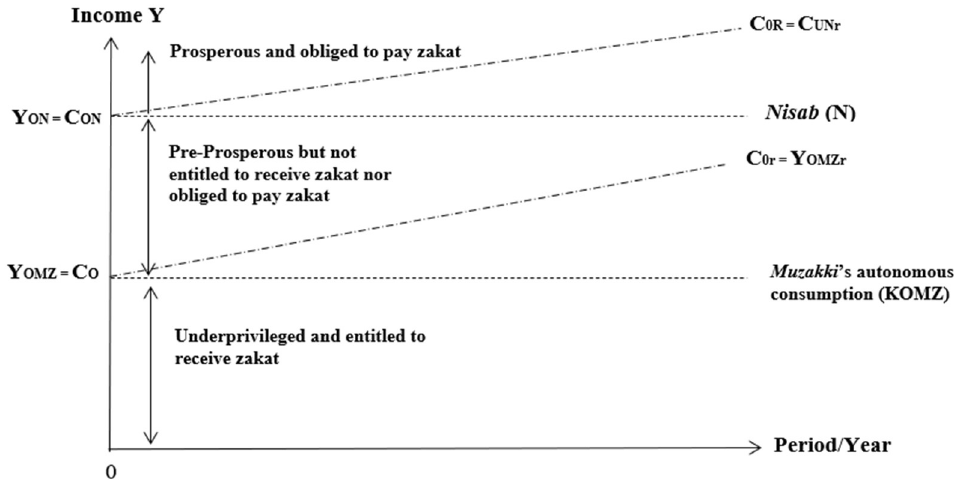
Fig 3. Level of economic society. Source: Kumara and Ryandono